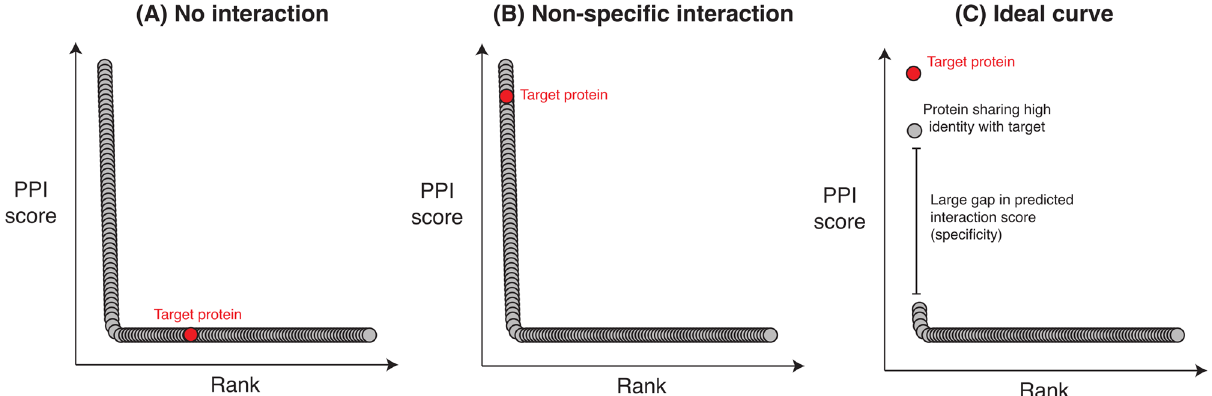
Figure 2. Representative one-to-all curves. Many one-to-all curves adopt one of three morphologies: ( A ) no interaction between the peptide and the target, ( B ) non-specific interaction where the peptide is predicted